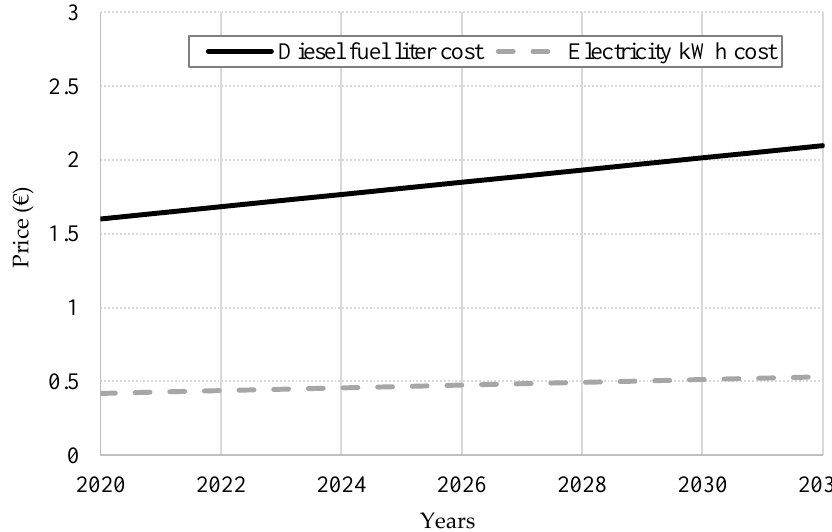
Figure 20. Regression analysis from a 5-year moving average of the diesel fuel price and 2-year moving average of the electricity price in Italy. Source: Authors’ elaboration. Table 3. Energy demand and diesel fuel consumption for the compactor truck for the considered collection scenario.